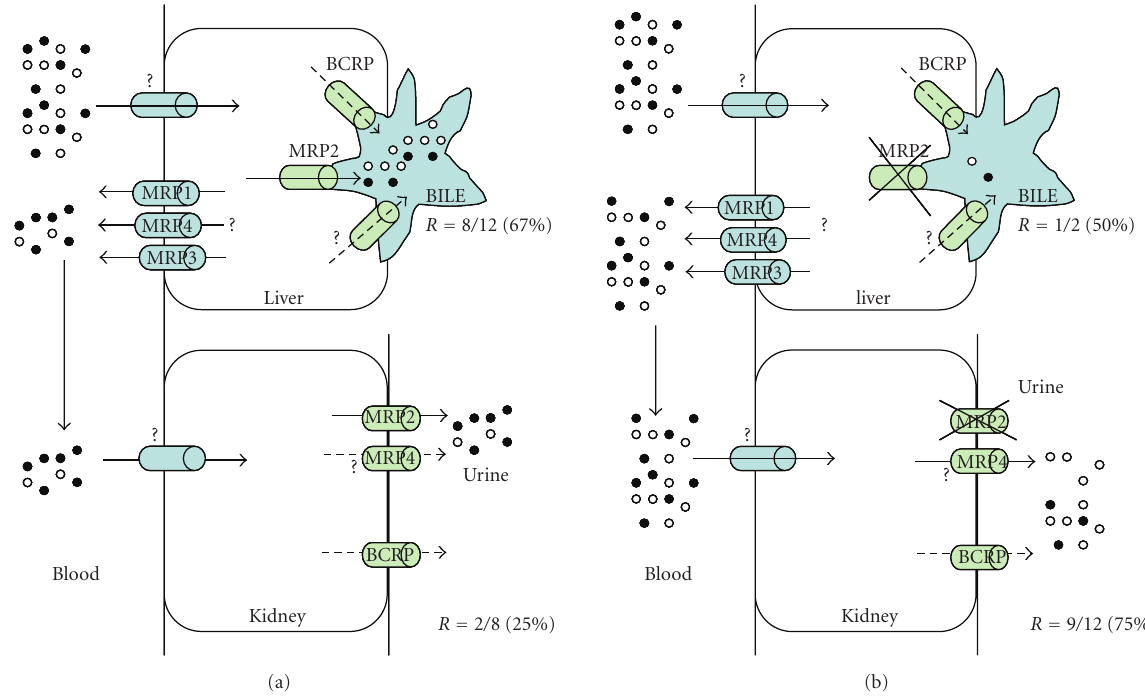
Figure 1: Proposed physiopathologic pathway for coproporphyrin elimination. This model was established on the basis of experimental data for both structure-a ffi nity relationships for the interaction between coproporphyrin isomers and MRP2 [12] and of the measurement of coproporphyrin excretion in the bile and urine of Mrp2 − / − or wild-type rats [6]. Calculations were based on an equimolar perfusion of coproporphyrin isomers in blood (for illustration, 10 molecules of each isomer are considered) and on the higher a ffi nity of MRP2 for isomer I than for isomer III. The white squares represent molecules of isomer I and the black squares molecules of isomer III. Each part of the figure illustrates a particular situation: physiologic conditions (a); no MRP2 activity (b). R represents the UCP I/(I + III) ratio, calculated as the number of molecules of isomer I over the total number of molecules of isomer I and isomer III. In physiologic